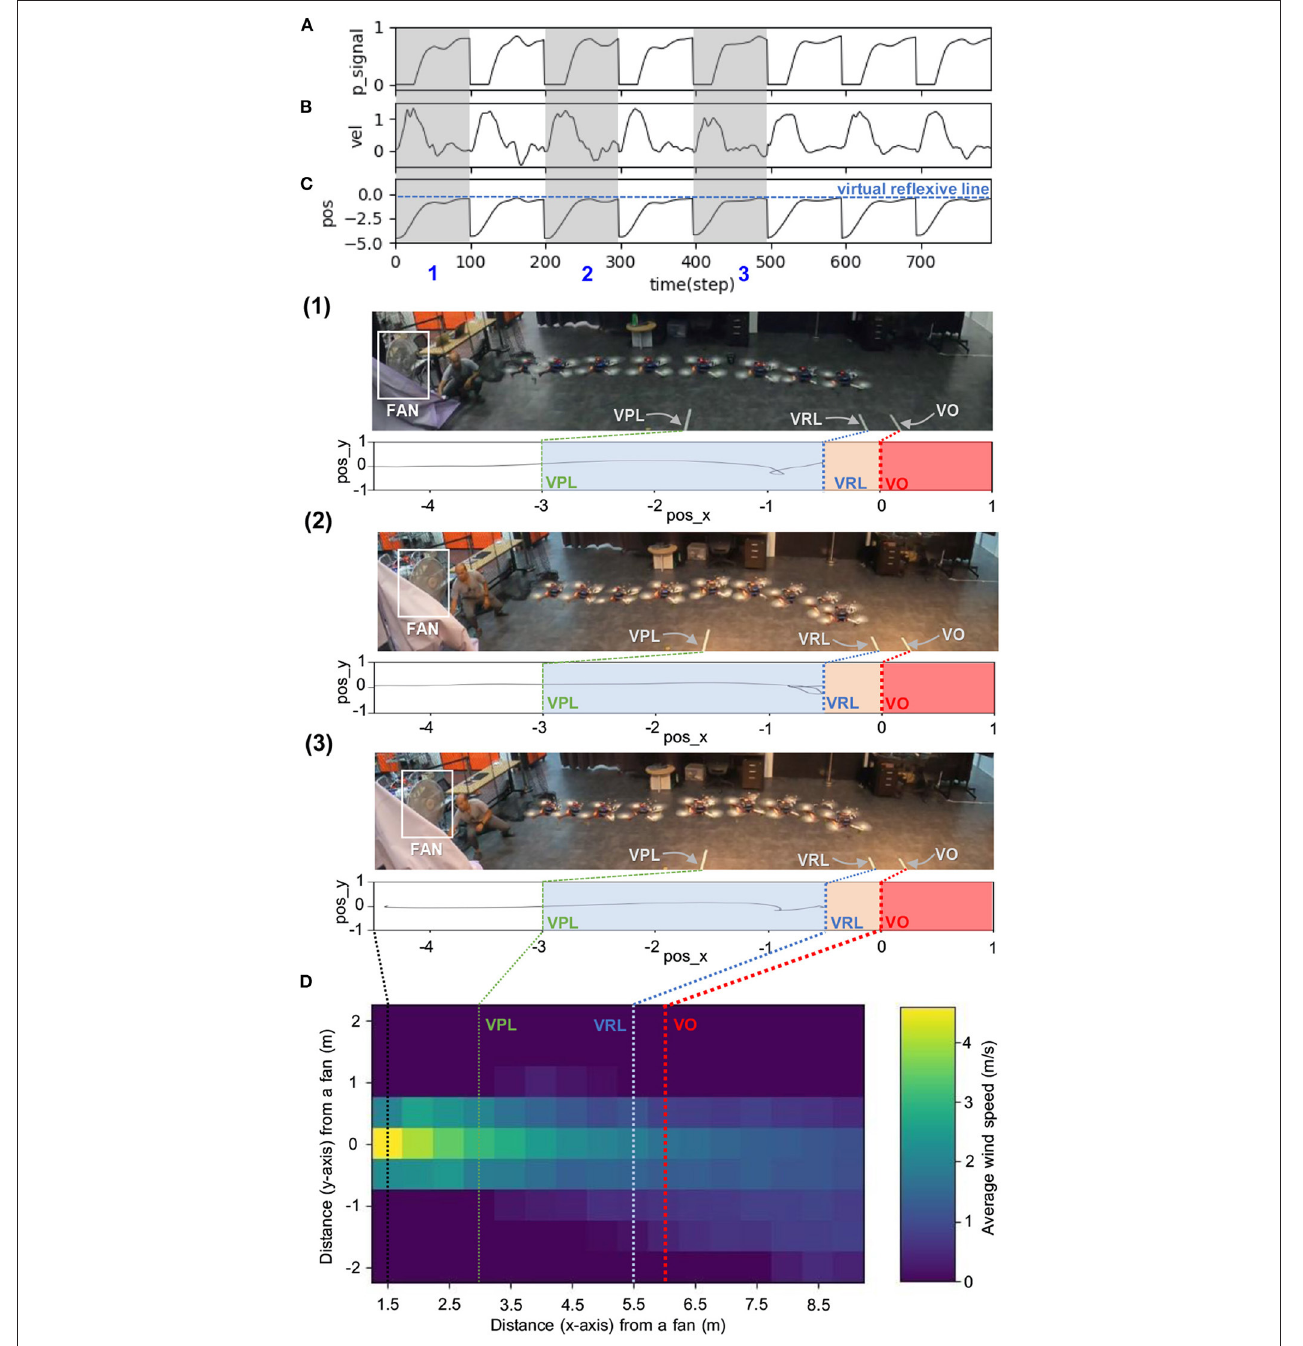
FIGURE 9 | Real-time data when flying the UAV with wind perturbation. The UAV flew at a maximum speed of 1.0 m/s and used an approximated predictive weight of 1.07 (obtained from Figure 7 ) as the initial weight. Each graph shows: (A) predictive signal, (B) actual speed (x-axis) of the UAV, (C) position on the x-axis of the UAV compared to the virtual reflexive line (blue line), and (D) wind speed gradient. The gray areas represent three periods, showing the position of the UAV with respect to the virtual predictive line (VPL), virtual reflexive line (VRL), and virtual obstacle (VO) in three snapshots together with the corresponding estimated trajectories (1, 2, 3). A video of this experiment can be viewed on www.manoonpong.com/DSA/video2.mp4.